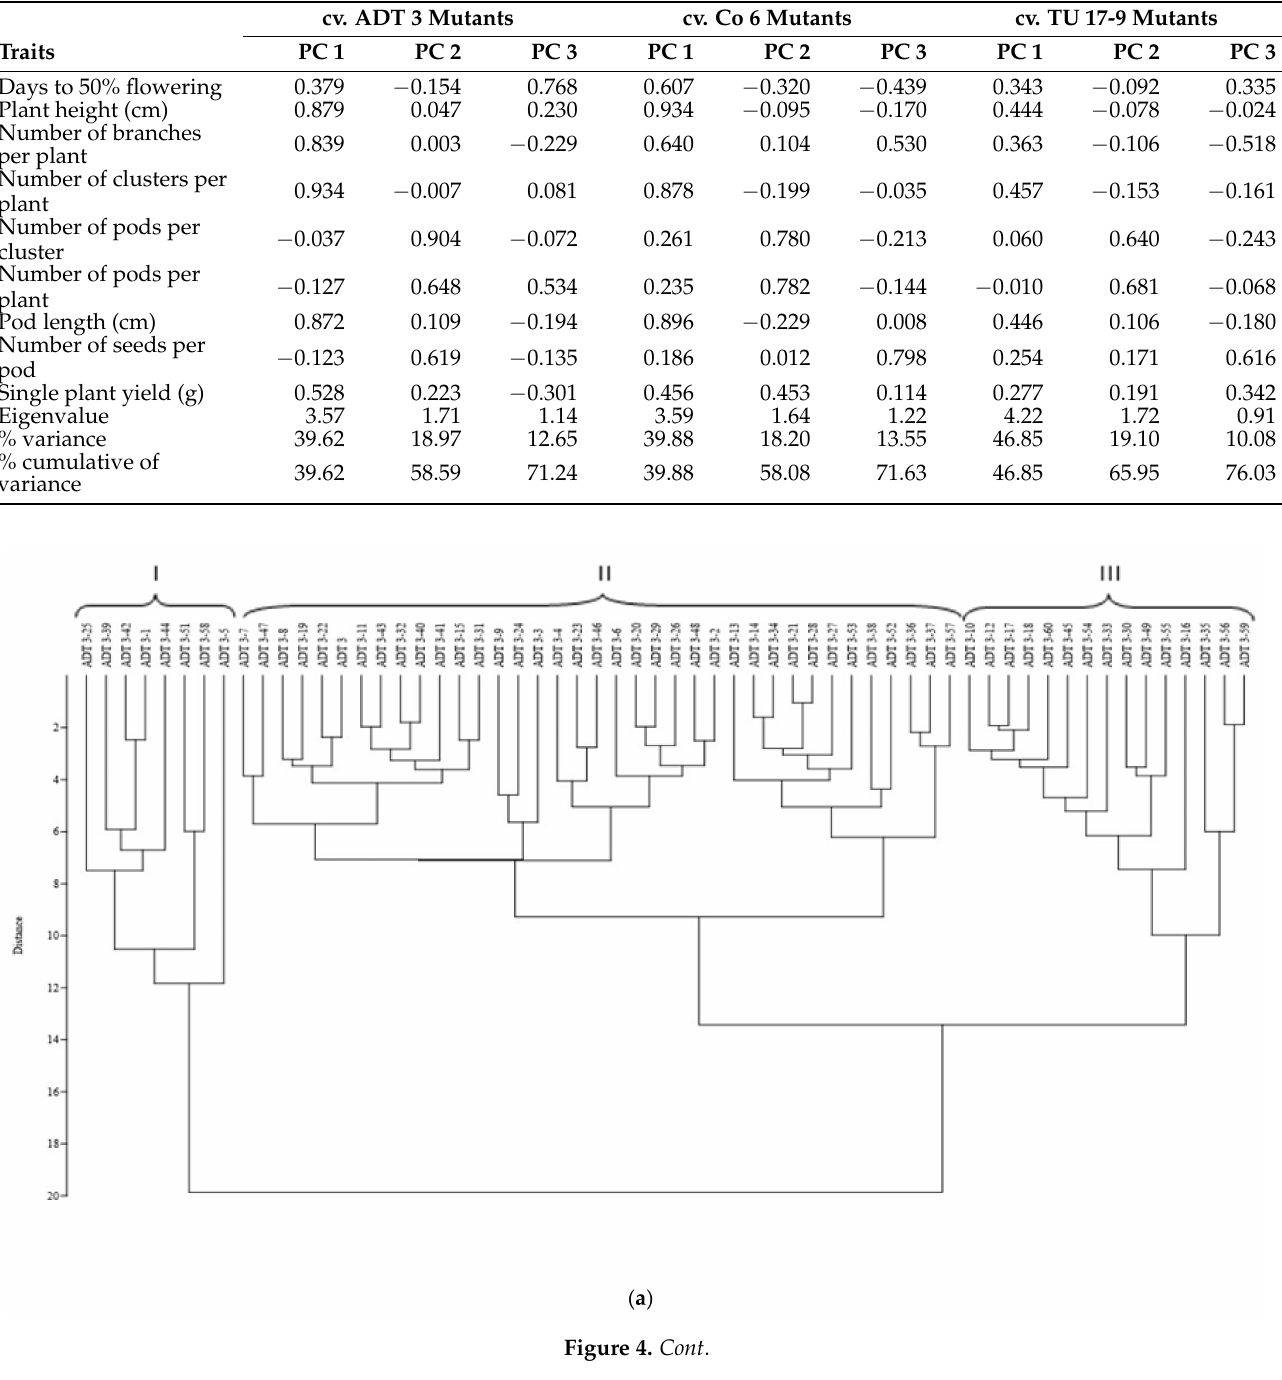
Table 3. Vector loadings and percentage of variation explained by the first three principal components after assessing the yield-related traits in a mutant population of three blackgram